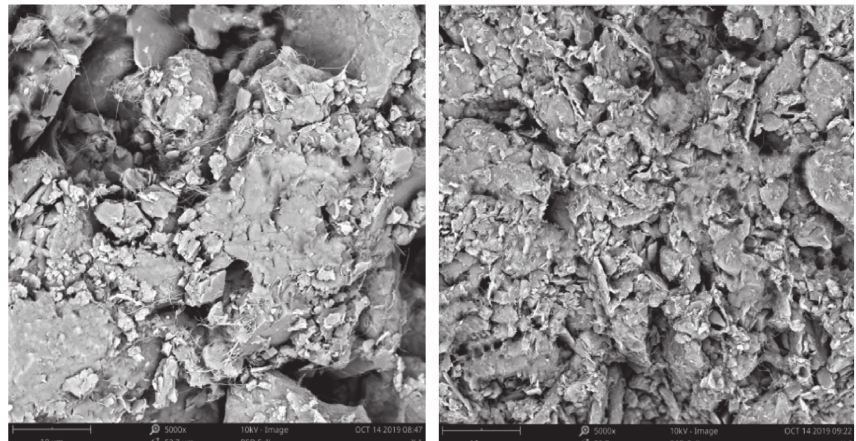
Figure 8: SEM photos of undisturbed soil.